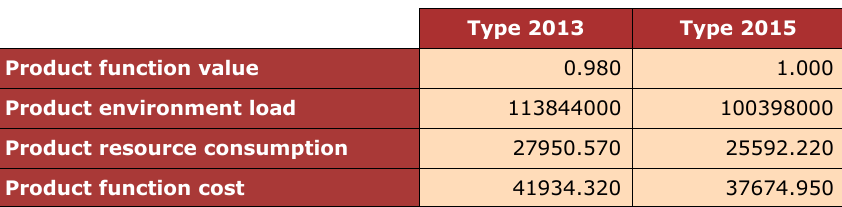
Table 5. X factor and Z factor calculation